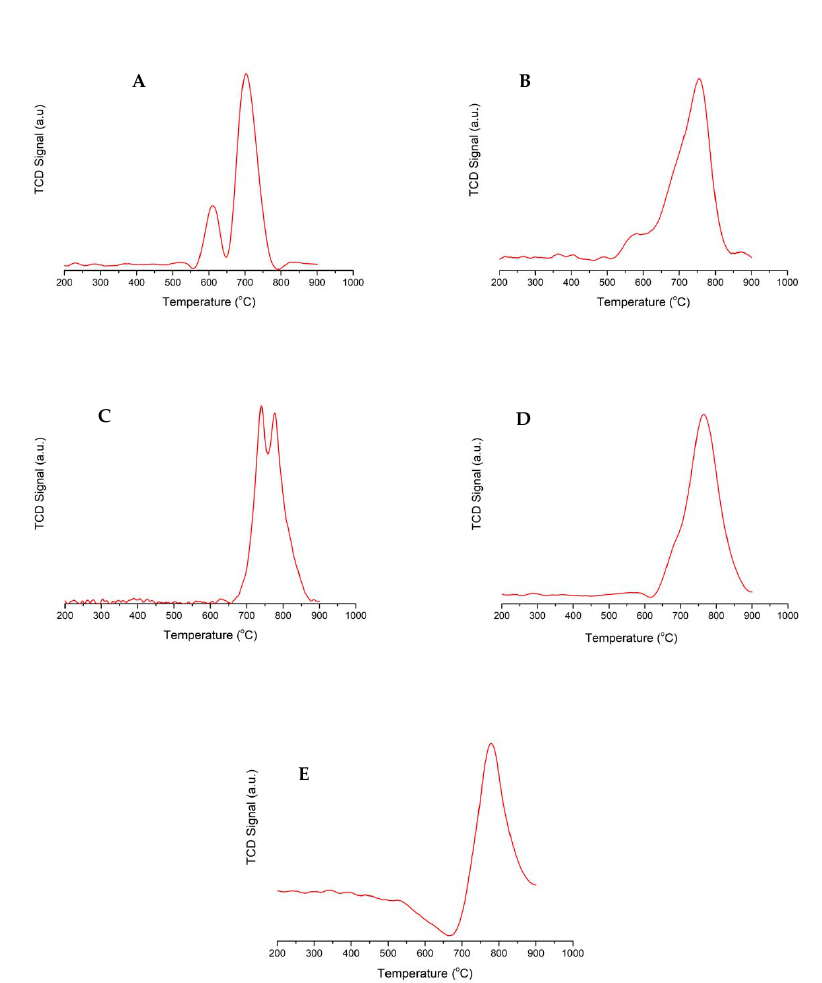
Figure 5. H 2 -TPR Profiles of ( A ) Ga-NaY, ( B ) MgGa-NaY, ( C ) CaGa-NaY, ( D ) SrGa-NaY, ( E ) Figure 5. H 2 ‐ TPR Profiles of ( A ) Ga ‐ NaY, ( B ) MgGa ‐ NaY, ( C ) CaGa ‐ NaY, ( D ) SrGa ‐ NaY, ( E ) BaGa ‐ NaY.